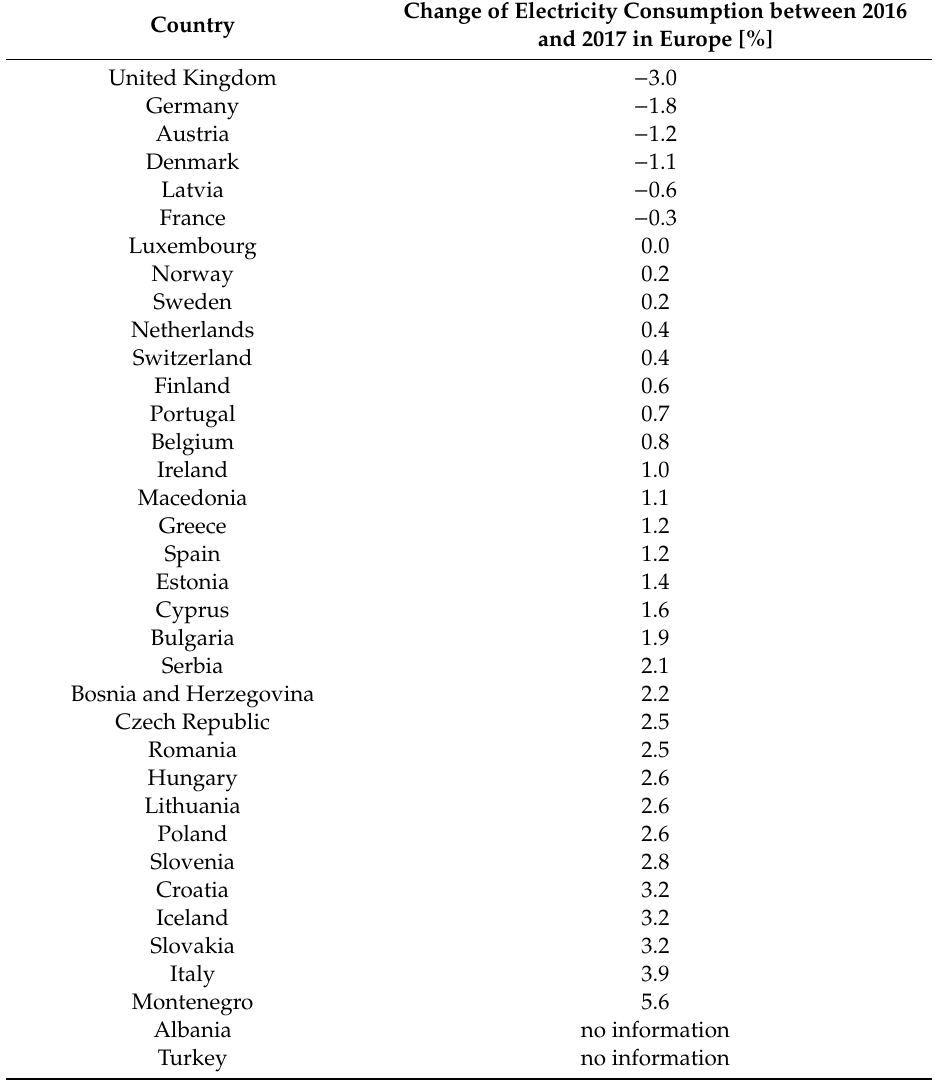
Table 2. Evolution of electricity consumption between 2016 and 2017 in Europe [41]. Change of Electricity Consumption between 2016 Country and 2017 in Europe [%] United Kingdom − 3.0 Germany − 1.8 −